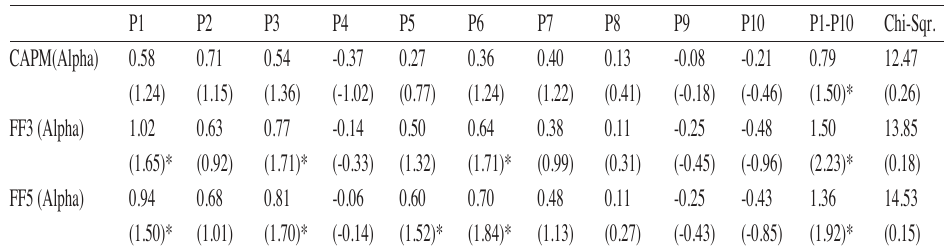
Table 3: Jensen Alpha of Value Weighted (VW) Asset Growth